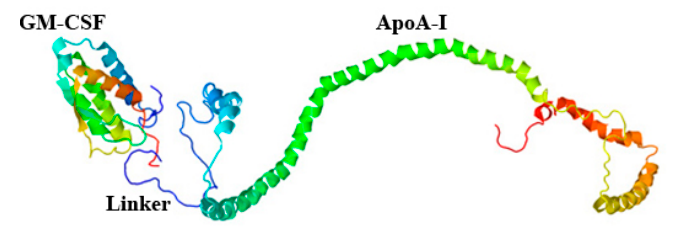
Figure 1. Construction of the pPICZ α A/ryGM-CSF-link-ApoA-I recombinant plasmid. Plasmid pPICZ α A/ryGM-CSF-link-ApoA-I was designed to express the chimeric